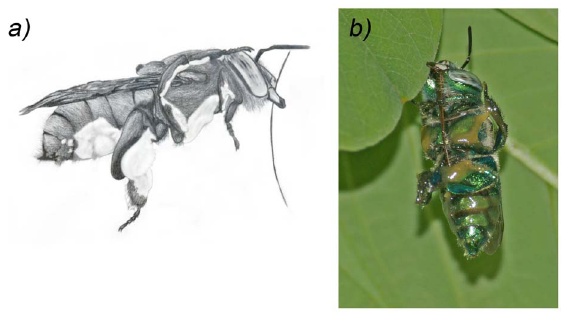
Figure 4. Manipulation of pollen provisions. Posture of a female E. viridissima during manipulation of nectar enriched pollen provisions, kneading. a) Schematic drawing of lateral view, with the nectar-pollen mixture rendered in white. b) Ventral view with the nectar-pollen mixture spread across the ventral meso- and metasoma as well as the